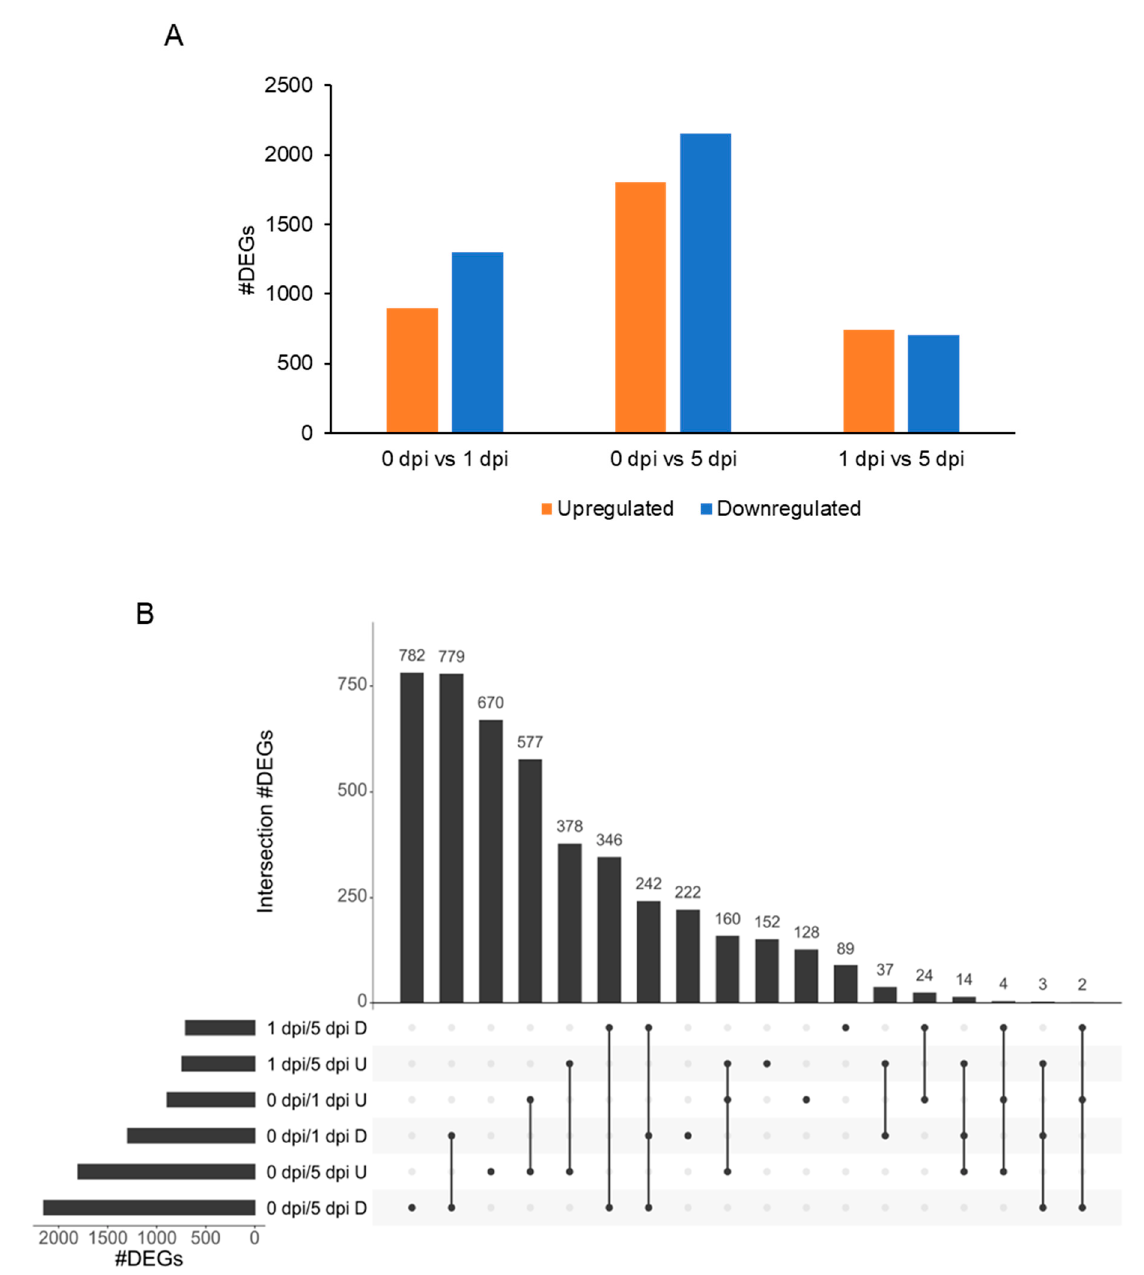
Figure 8. Organization of the 4609 WCR differentially expressed genes (DEGs). ( A ) Barplot of the number of upregulated (orange) and downregulated (blue) DEGs. ( B ) UpSet intersection plot of DEGs. Intersections are represented by a line connected to one or more dots. The number of common DEGs are indicated at the top of each bar, and conditions are organized according to the number of DEGs. D, downregulated in cond2; U, upregulated in cond2 when cond1/cond2.